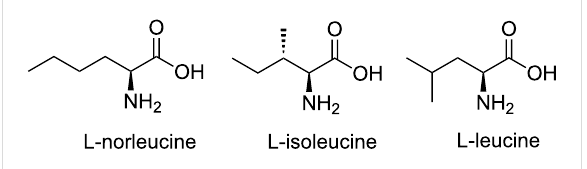
Figure 1: L-Norleucine, L-isoleucine, and